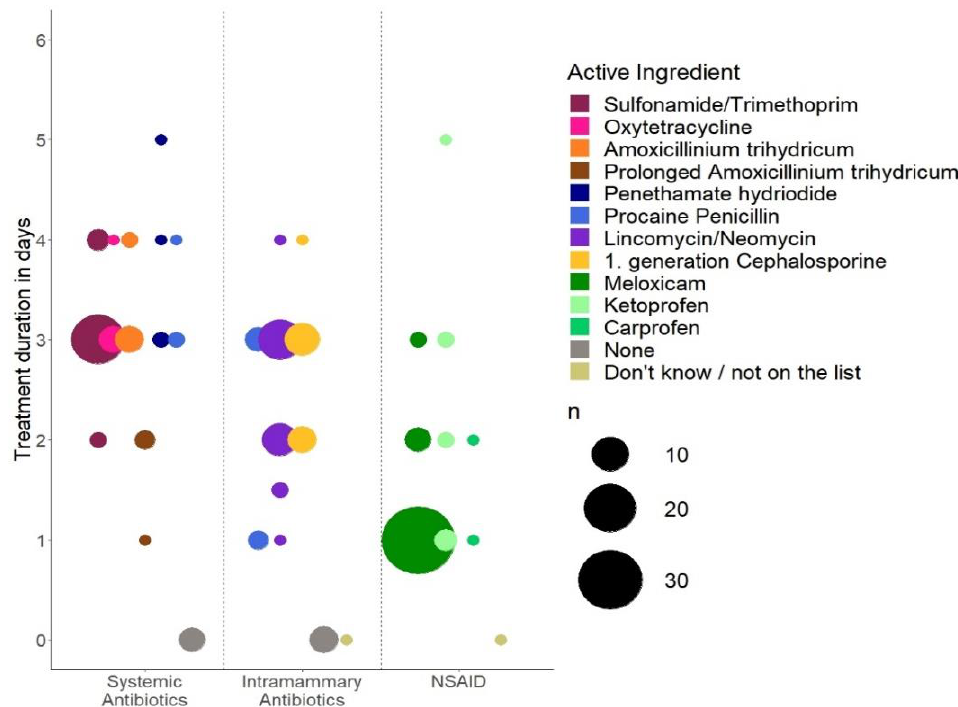
Figure 3. Prescription protocol of systemic antibiotics, local antibiotics and NSAIDs used often or always by Danish veterinarians ( n = 58) for a herd diagnosis of “ acute mastitis ” .